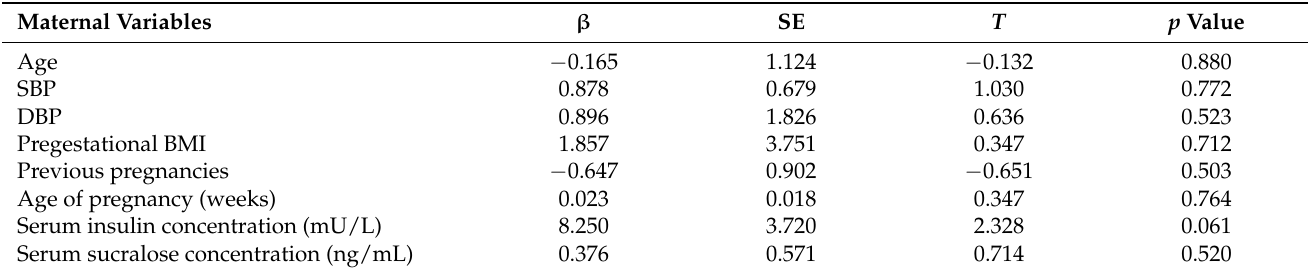
Table 2. Multiple linear regression analysis to estimate the influence of maternal variables in neonates’ birth weight.